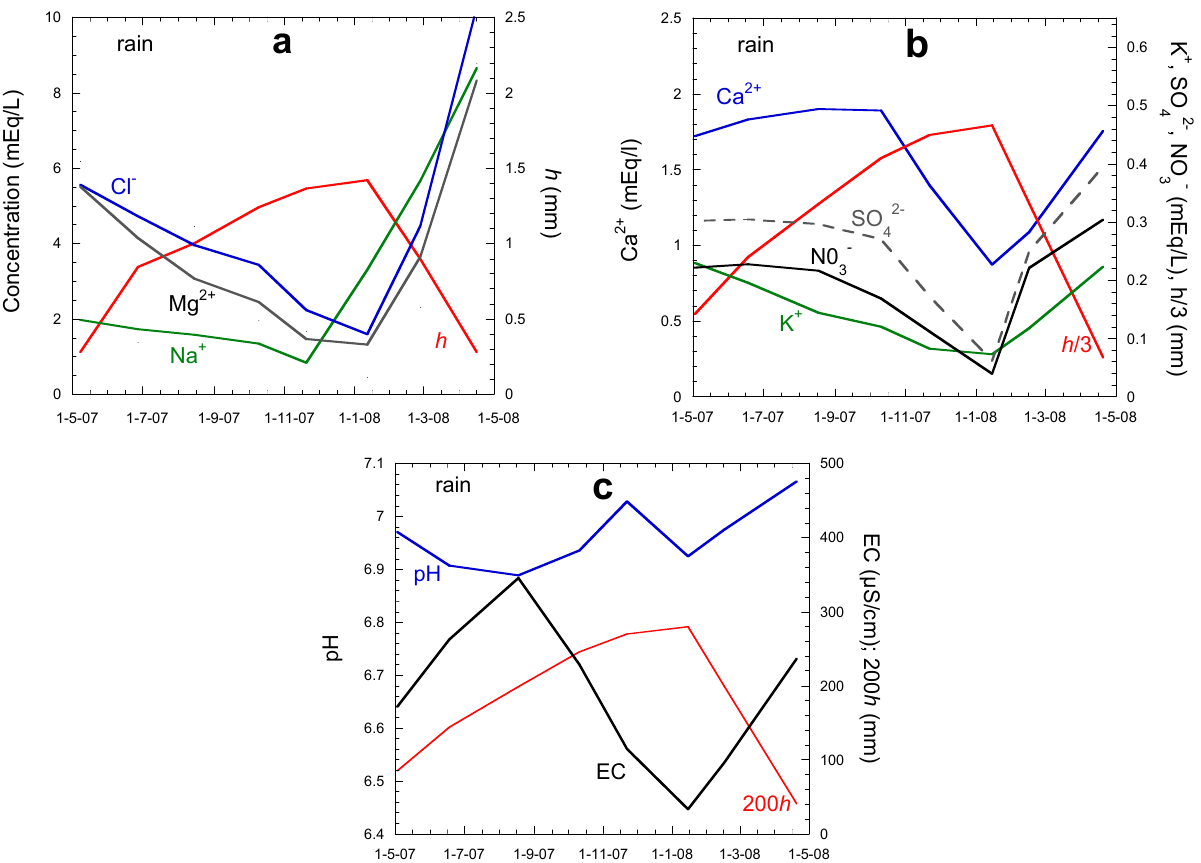
Figure 20. Evolution of rain ions. ( a ) Comparative evolution of sea anions and cations concentrations and rain volume per unit area h (mm). ( b ) Same as ( a ) but with continental ions. ( c ) Evolution of electric conductivity EC ( µ S · cm − 1 ), pH and rain volume per unit area h (mm). All curves are smoothed fit of single values.